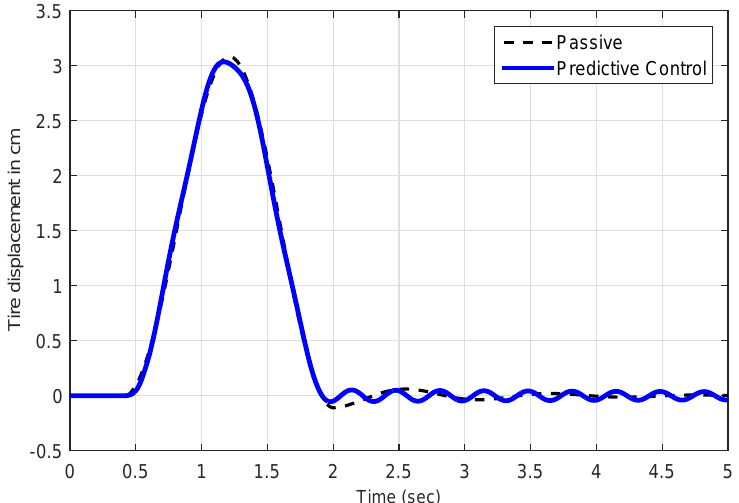
Figure 8. Tire or unsprung mass displacement for the predictive controlled and passive